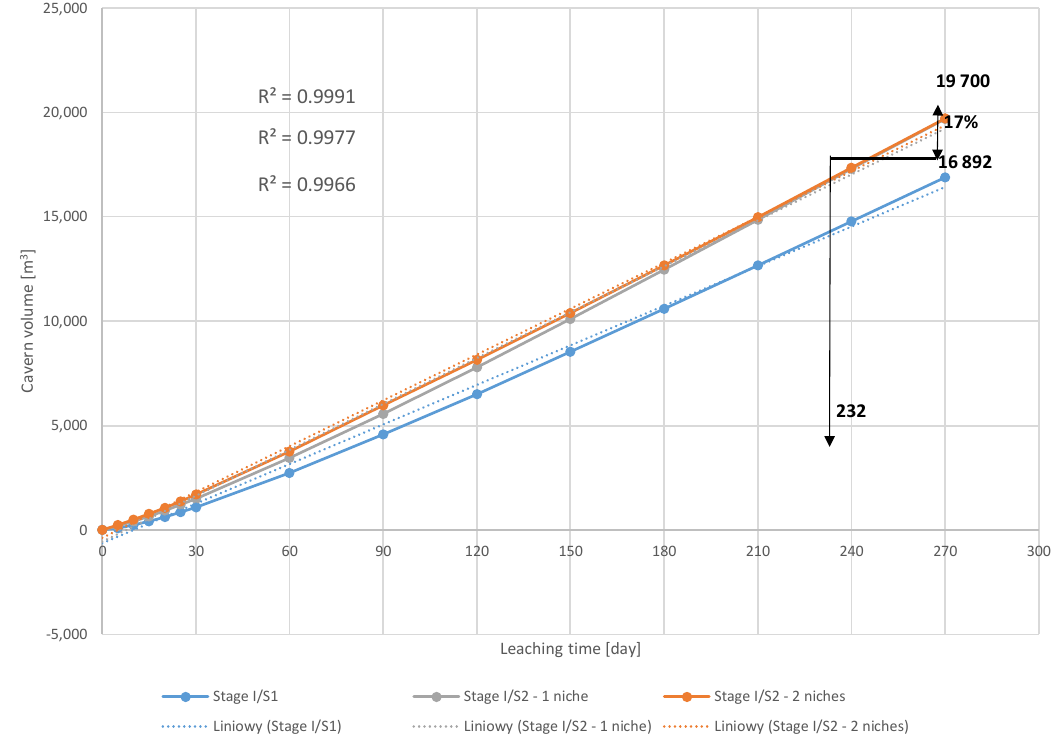
0.9977R² = 0.9991 0.9966R² = R² =